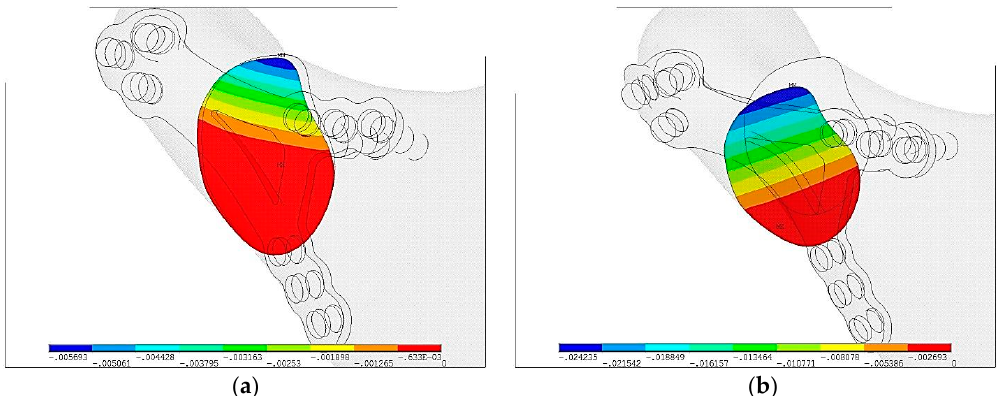
Figure 7. The size of the fissure between bone ends just after plate fixation in the maximal loading according to the literature [16]: ( a ) Ti-6Al-4V plate fixation, g max = 0.0057 mm, ( b ) PLLA plate fixation, g max = 0.024 mm.